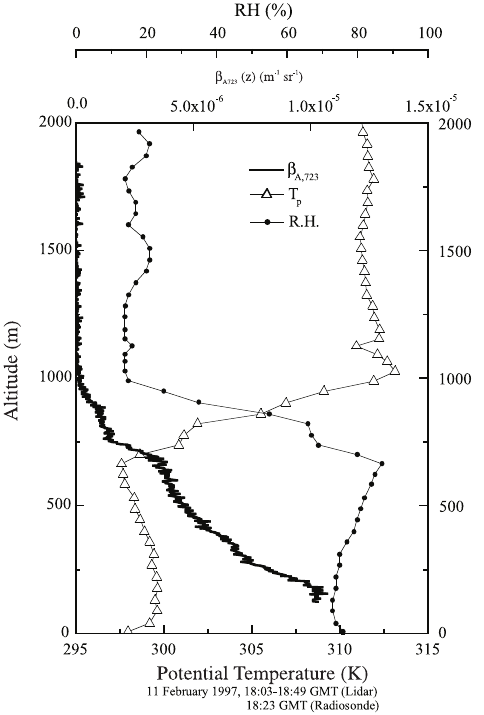
Fig. 10. Vertical profi les of aerosol backscattering co- effi cient at 723 nm for 11 February 1997 (bold line) and simultaneous radiosonde profi les of potential temperature (open up triangles) and relative humidity (solid